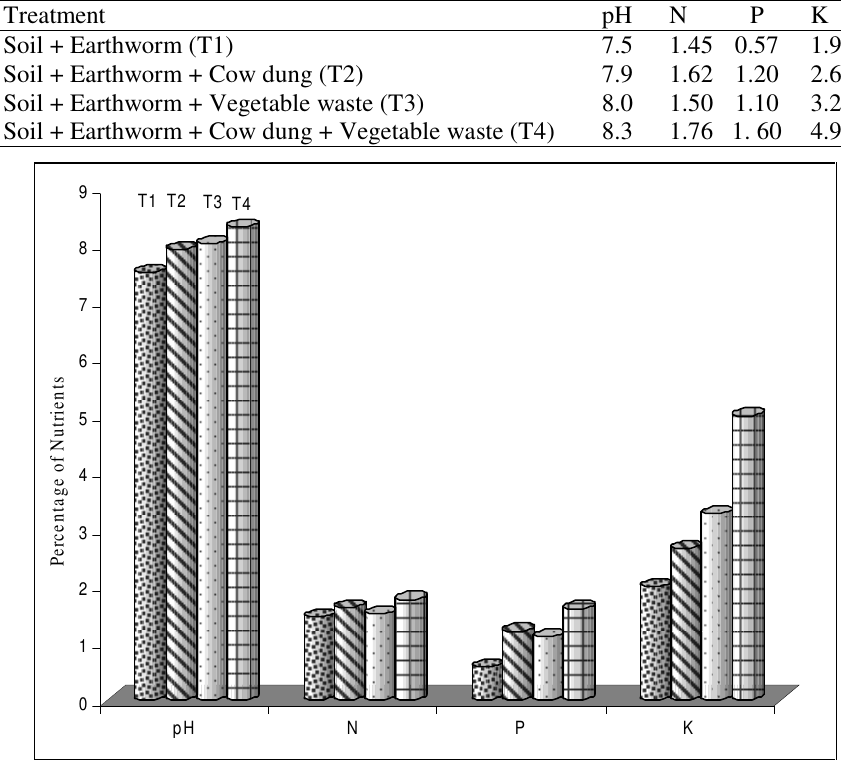
Figure 1. Comparison of the nutrients in the different treatments of vermicompost